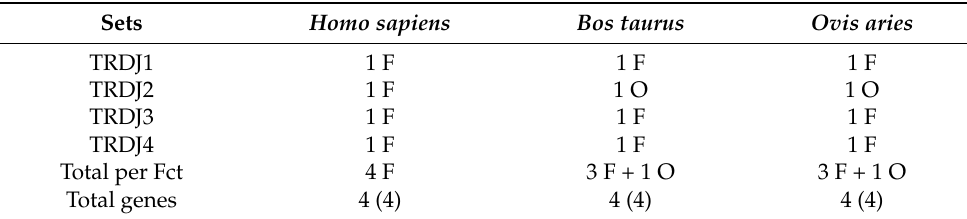
Table 6. IMGT Potential germline repertoires of the TRDJ sets in human ( Homo sapiens ), bovine ( Bos taurus ) and sheep ( Ovis aries